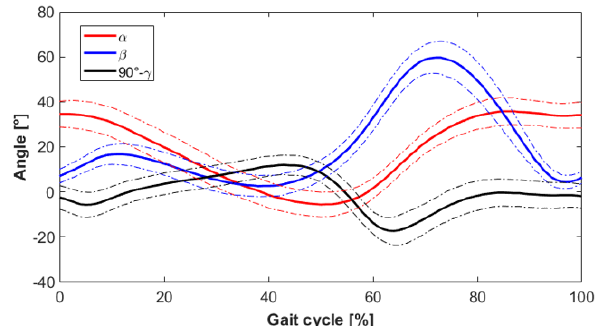
Figure 3. The diagram of the 3 angles of the lower limb during the gait (solid lines show the average values of the angles; dashed lines the standard deviation range): hip angle α , knee angle β , and ankle angle γ .